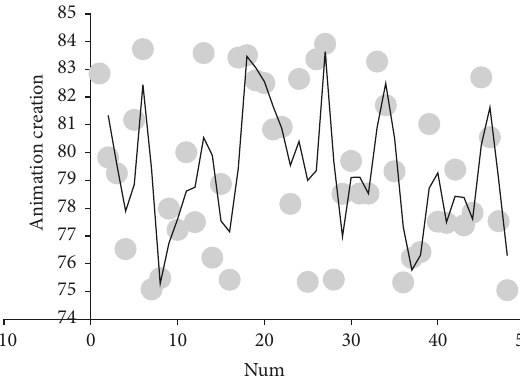
Figure 9: The effect of animation